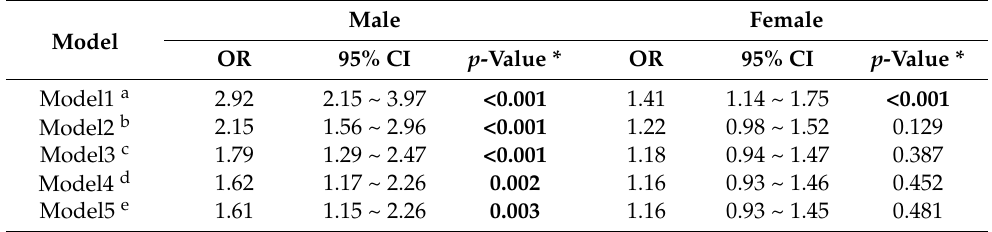
Table 3. Association between dental caries and handgrip strength according to